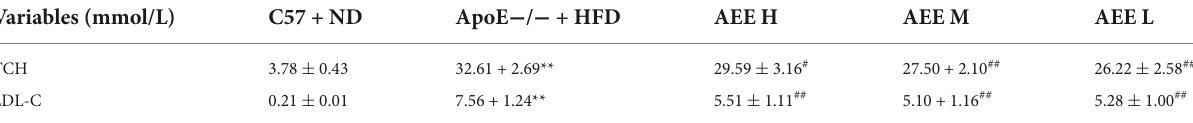
TABLE 1 Effect of AEE on blood lipids in mice.